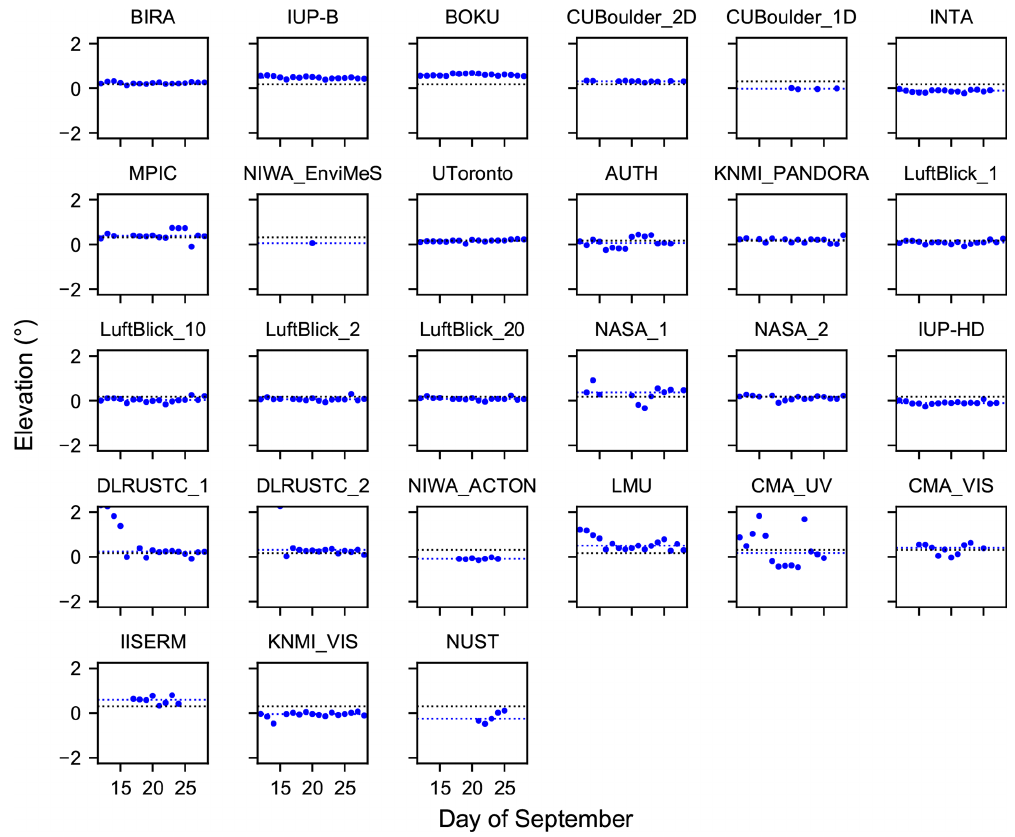
Figure 17. Overview of the daily results of the horizon scans for all participating instruments at 440nm. Additionally, in each subplot the median horizon elevation (dashed blue lines) and expected horizon elevation (dashed black lines) for the corresponding instrument are indicated.